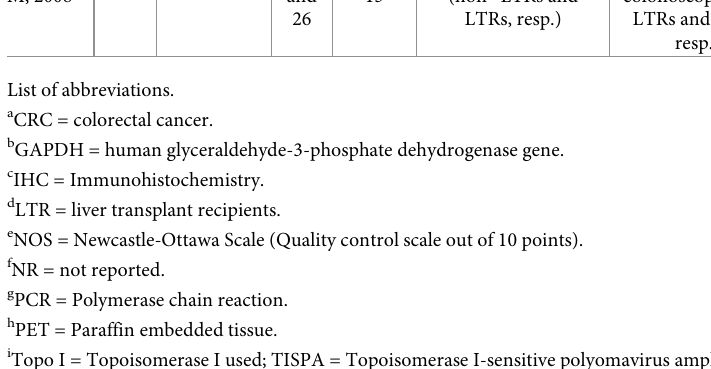
List of abbreviations. a CRC = colorectal cancer. b GAPDH = human glyceraldehyde-3-phosphate dehydrogenase gene. c IHC = Immunohistochemistry. d LTR = liver transplant recipients. e NOS = Newcastle-Ottawa Scale (Quality control scale out of 10 points). f NR = not reported. g PCR = Polymerase chain reaction. h PET = Paraffin embedded tissue. i